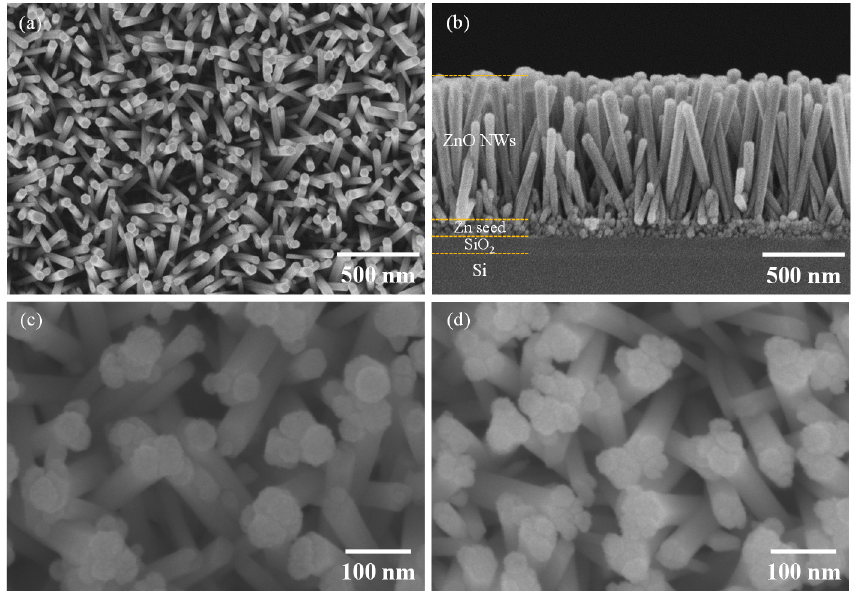
Figure 2. SEM images of ( a ) top view and ( b ) cross-sectional view of as-grown ZnO NWs and ZnO NWs processed for ( c ) 5 and ( d ) 15 s under excessive conditions.